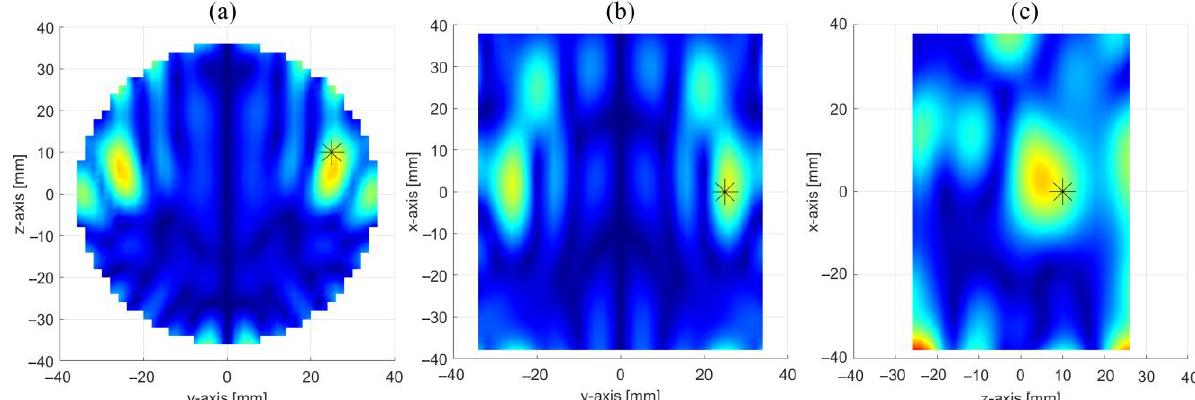
Figure 6. Reconstruction of the inclusion through the PSP-based approach: images in three orthogonal cut planes crossing the center of the inclusion (stars give the position of the inclusion), i.e., ( a ) x = 0 cm cut plane, ( b ) z = 10 cm cut plane and ( c ) y = 25 cm cut plane.